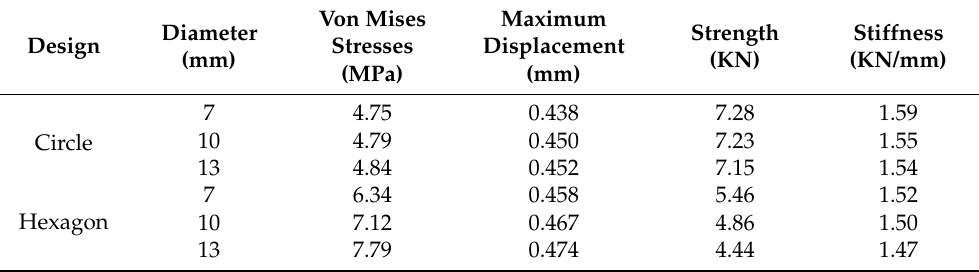
Table 2. Results of circular and hexagonal designs for different sizes. Results are based on external fixator devices made in